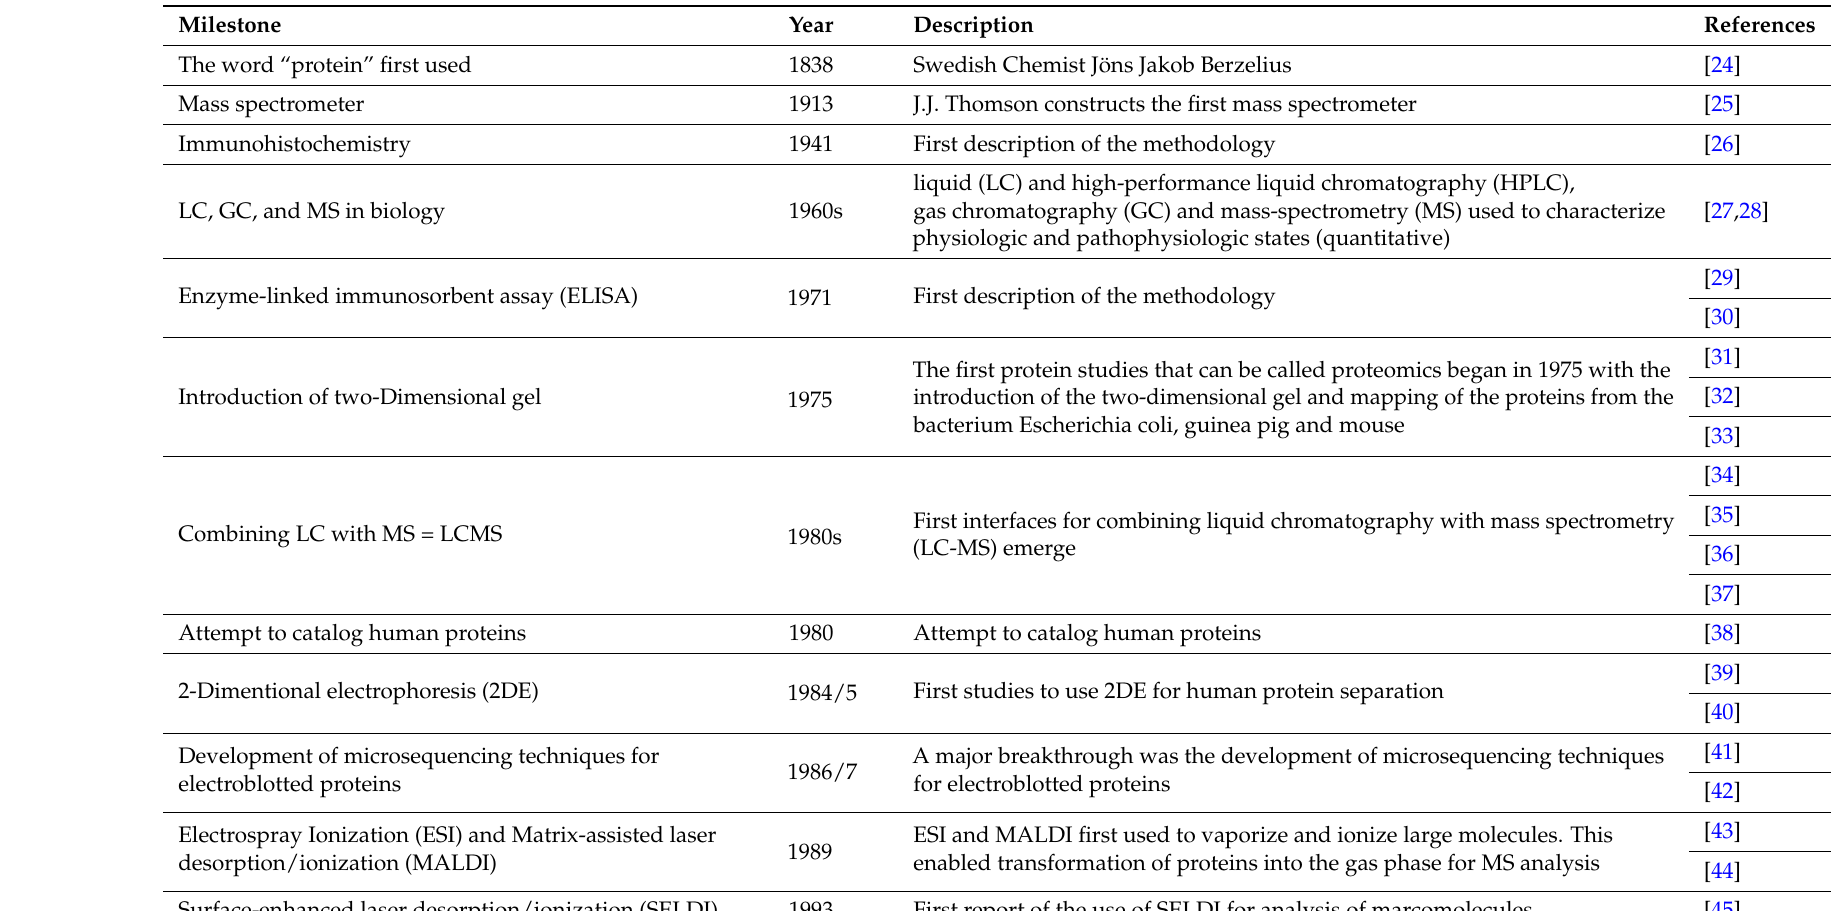
Table 1. Historical milestones relevant to